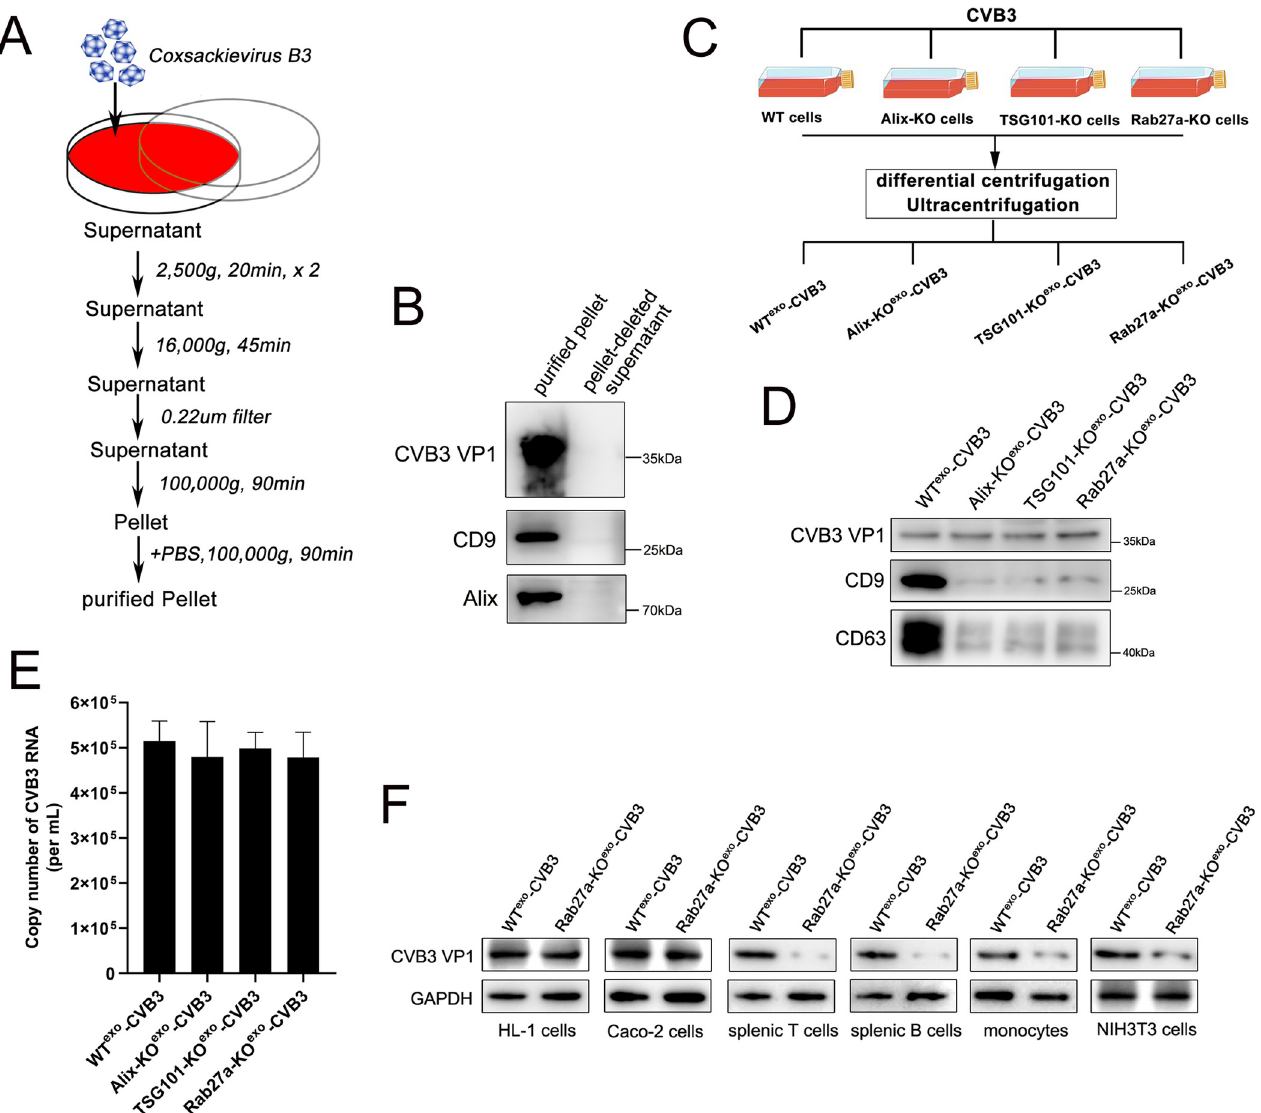
Fig 2. CVB3 entry into receptor-negative cells depended on exosomes. (A) Caco-2 cells were infected with coxsackievirus B3 at 0.05 TCID 50 for 24h. The purified pellet containing exosomes and virion were isolated from culture supernatant by differential ultracentrifugation. (B) Western blot analysis of the purified pellet and pellet-deleted supernatant by CVB3 VP1 and exosomal markers CD9 and Alix. (C, D and E) The purified pellets were isolated from supernatant of CVB3-infected wild-type cells(WT cells) or knockout cells(KO cells). Equal number of WT or KO Caco-2 cells were infection with 0.05 TCID 50 of CVB3 for 24h and the supernatants were collected, followed by differential ultracentrifugation(C). The protein levels of CVB3 VP1, exosomal markers CD9 and CD63 in different pellet were measured by western blot analysis(D). And the comparison of CVB3 RNA copy number by real-time PCR analysis(E). Data are shown as mean ± SD of three independent experiments. (F) Western blot analysis of viral protein VP1 in different type of cells after incubating with purified pellets that isolated from CVB3-infected WT cells or Rab27a-KO cells. Purified pellet containing exosomes and virion was isolated from equal numbers of infected WT cells or Rab27a-KO cells and then incubated each cell type for 12h. 1–10 (F1-F10) were used for western blotting to analyze the distribution of proteins in the virion fraction containing exosomes. We found that the exosomal marker CD9 was predomi- nantly observed in F5-F7, while the structural protein VP1 of CVB3 was detected at the highest levels in F8-F10, indicating the presence of CVB3 virions in the fractions with the highest den- sity (Fig 3G and 3H). Nevertheless, a portion of virions was found floating on an iodixanol